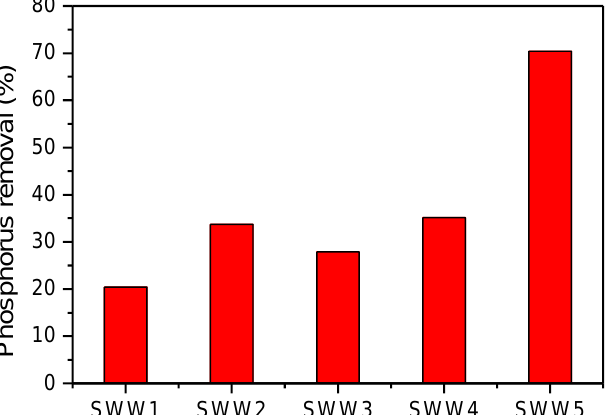
Figure 15. Phosphorus removal (%) from spontaneous precipitation of struvite in simulated wastew- ater using as magnesium source Mg(OH) 2 derived from the hydrothermal treatment of MgO. ve advantage, especially in case a continuous recovery process (e.g., fluidized bed) is used.